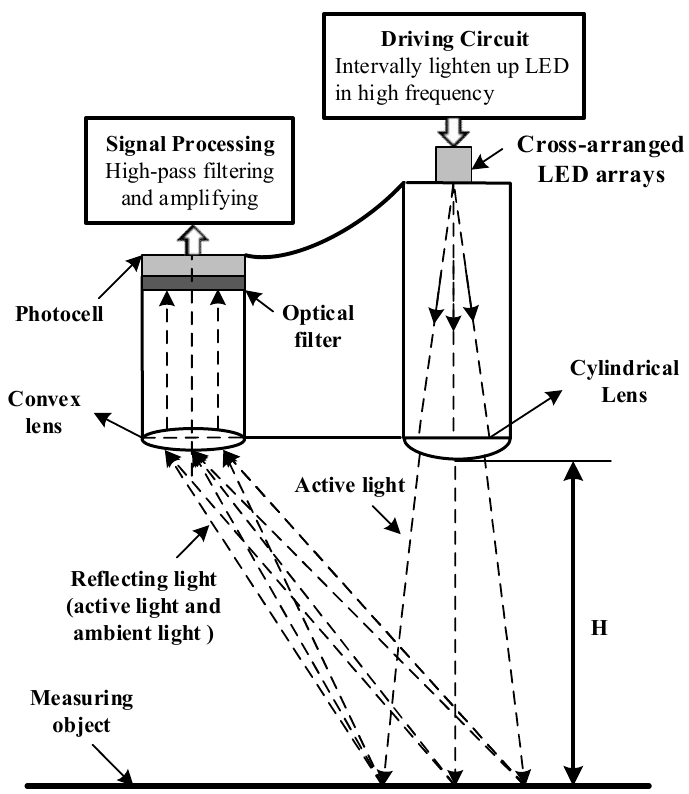
Figure 3. Working principle of dual-band reflectance spectrometer.